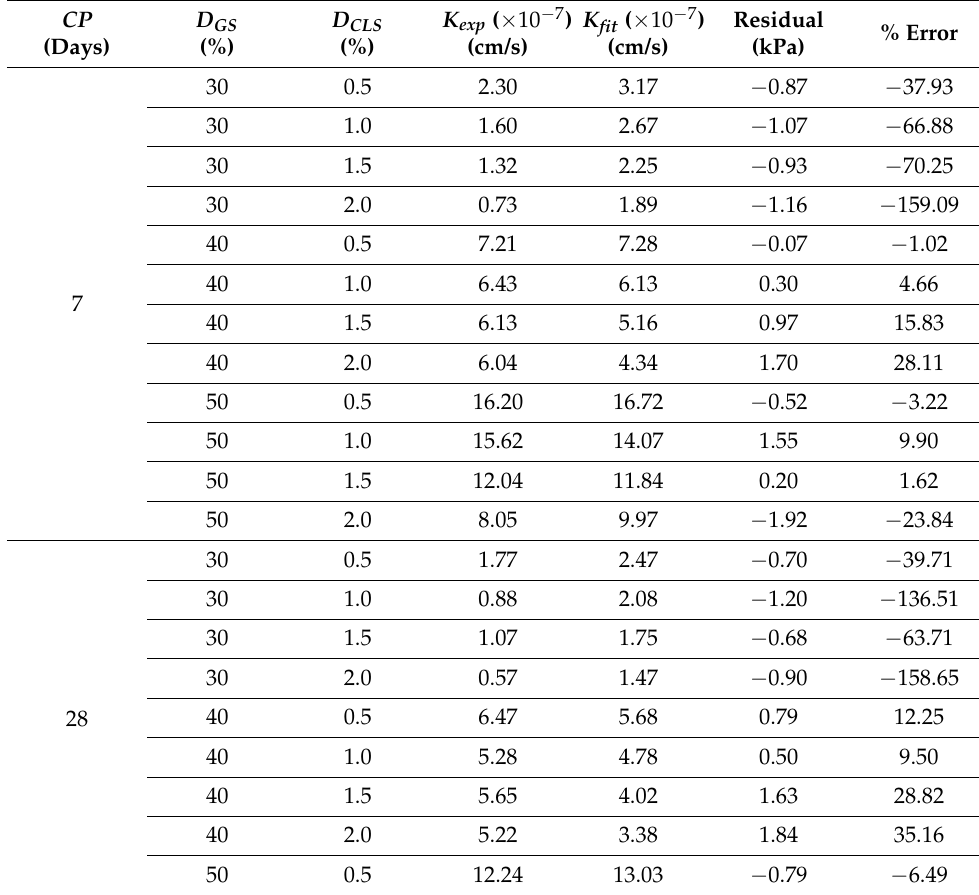
Table 10. The nonlinear equation for the hydraulic conductivity ( K fit ) of treated soil with granite sand (GS) and calcium lignosulphonate (CLS) measured after 7 and 14 days of